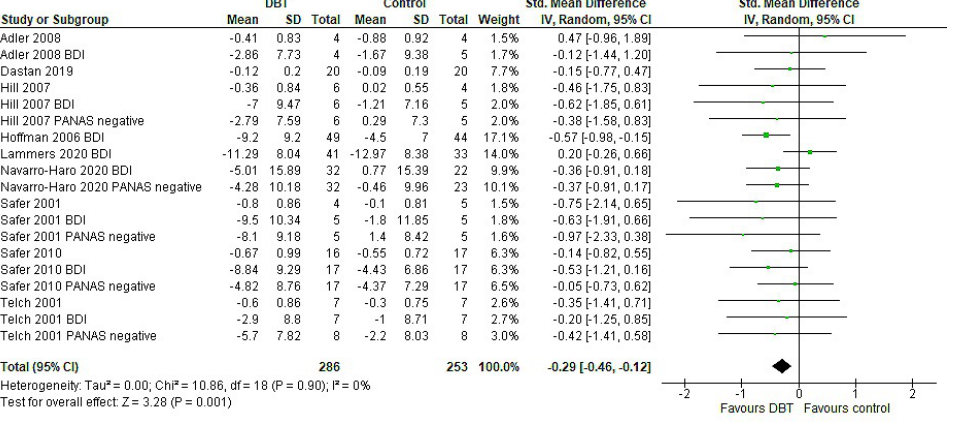
Figure 4. Forest plot: adjusted analysis of depressive symptoms including all relevant outcomes per